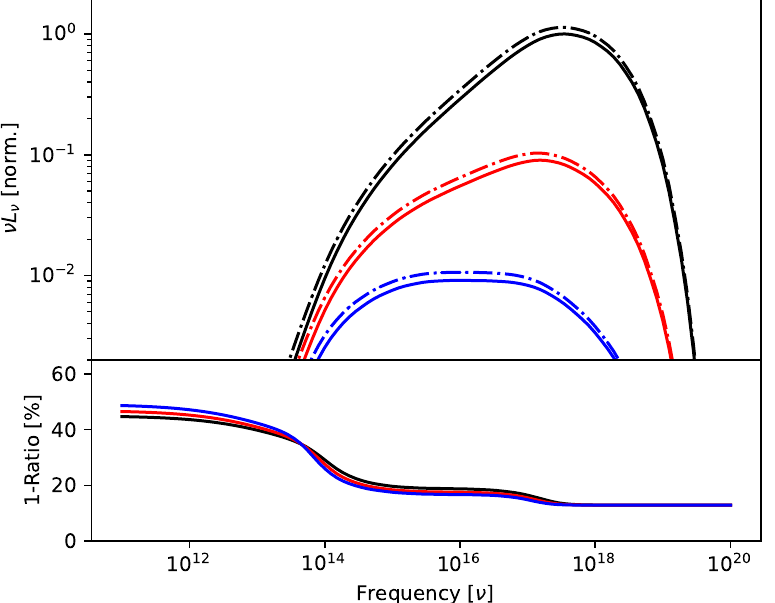
Figure 10. SSC emission computed with FLAREMODEL from a uniform emission region. SEDs with dashed line are obtained using the numerical ray-tracing approach, and solid ones are obtained with the numerical integration considering a uniform particle distribution. Figure from